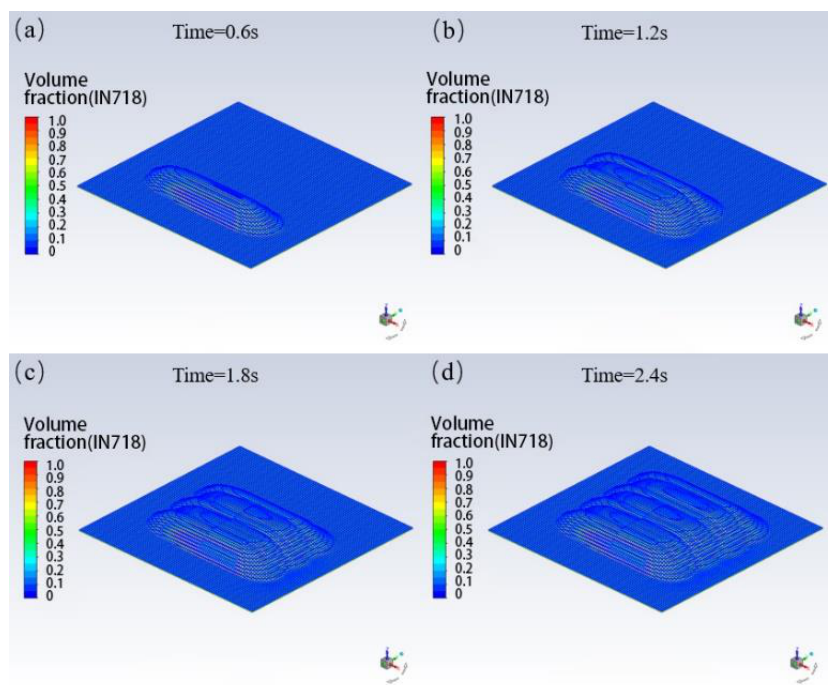
Figure 17. Variation of the shape of deposited layer with time for single layer multi-laser processing. ( a ) 0.6 s; ( b ) 1.2 s; ( c )1.8 s; ( d ) 2.4 s.